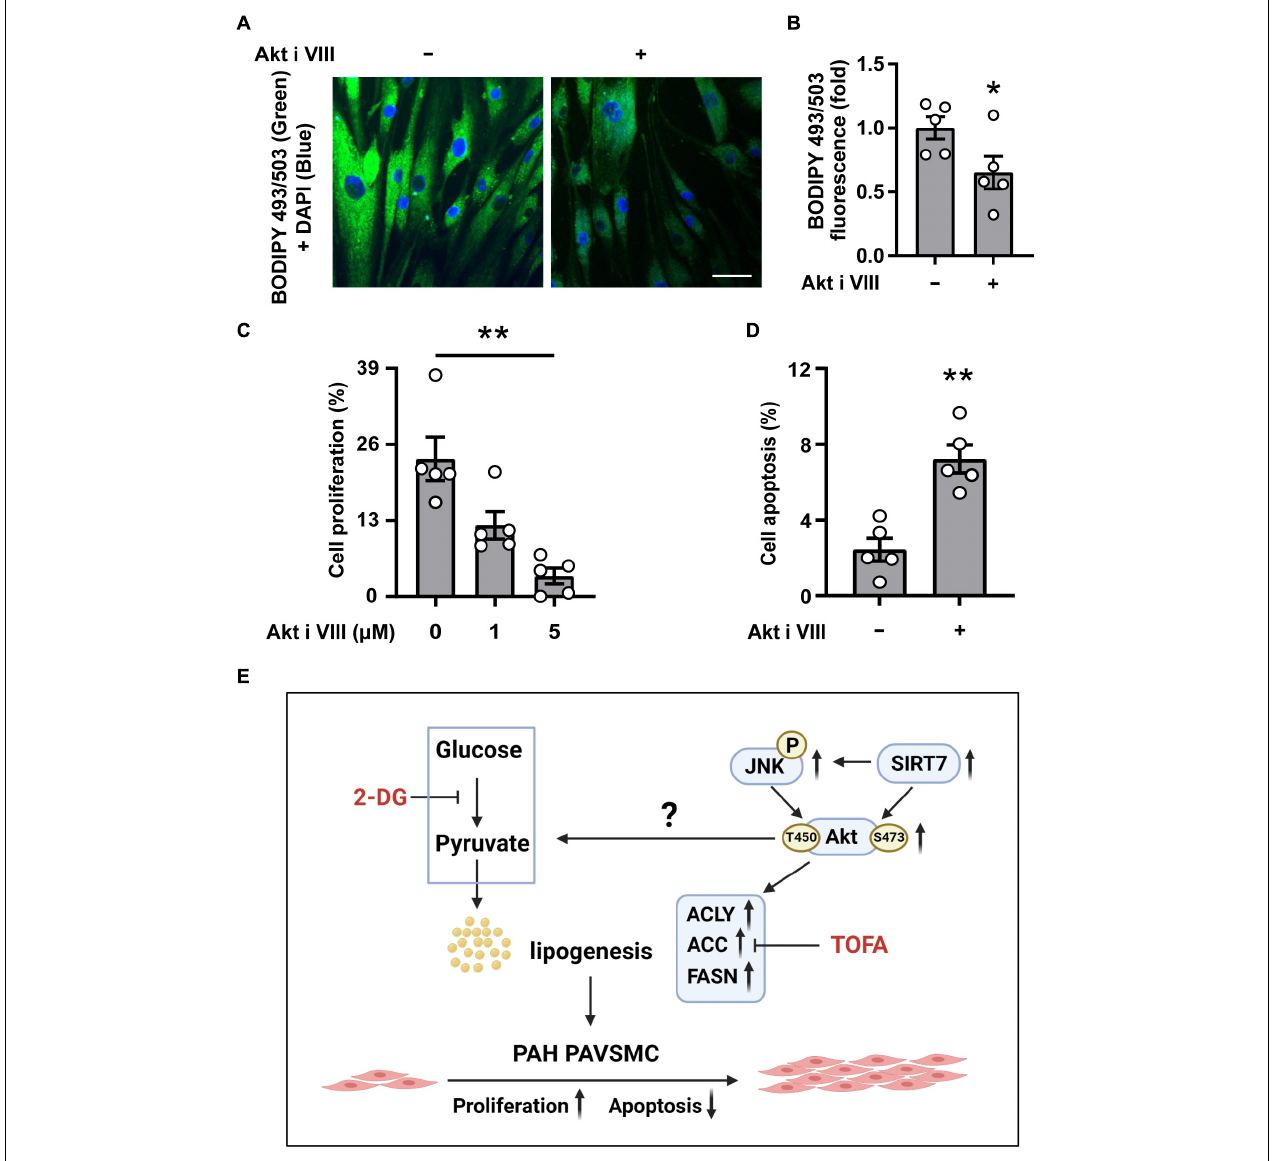
FIGURE 6 | Akt supports intracellular lipid levels, proliferation and survival of human PAH PAVSMC. (A,B) Human PAH PAVSMC were incubated in serum deprived media supplemented with 0.1% lipid deprived BSA in presence of Akt inhibitor VIII (10 µ M) or diluent. Forty-eight hours later neutral lipid accumulation was evaluated by fluorescent BODIPY 493/503 staining (green) followed by DAPI co-staining (blue) to detect nuclei. Representative images (A) and statistical analysis (B) are shown. Bar equals 50 µ m. Data are means ± SE, fold to the diluent-treated cells, n = 5 subjects/group, * p < 0.05 by Mann–Whitney U test. (C) Human PAH PAVSMC were serum deprived in media, supplemented with regular 0.1% BSA, and were treated with 1, 5 µ M (C) or 10 µ M (D) Akt inhibitor VIII or vehicle (0/-) for 48 h followed by proliferation (Ki-67) (C) or apoptosis (D) analyses. Data are percentage of Ki-67- or TUNEL- positive cells/total number of cells, means ± SE, n = 5 subjects/group. * p < 0.05 Kruskal–Wallis rank test with Dunn pairwise comparison post hoc test (C) or by Mann–Whitney U test (D) . (E) Schematic representation of the proposed regulation of the de novo lipid synthesis, required for increased proliferation and survival of PAVSMC in